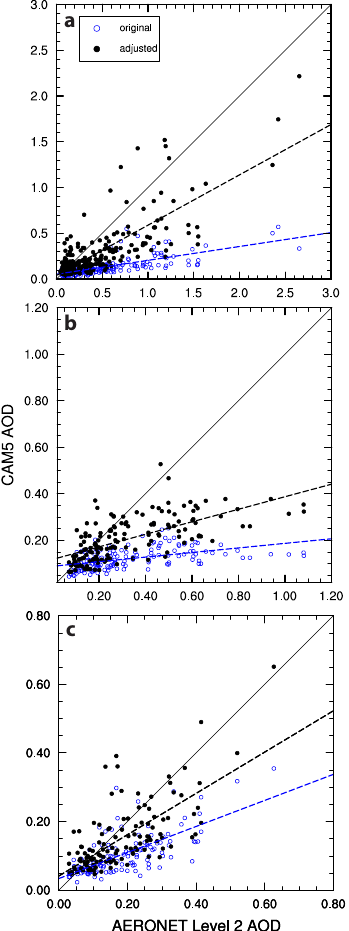
Fig. 3. Linear relations between CAM5 simulated aerosol optical depths (y-axis) and AERONET optical depths (x-axis) for the un- adjusted case (blue dots/line) and adjusted case (black dots/line), showing better agreement in the adjusted scenario. Regions are the same as Fig. 2: (a) South America (SAM), (b) southern Africa (SAF) and (c) equatorial Asia (EA). Only those months where CAM5 AOD from fire emissions was greater than or equal to 30% were used in our comparisons.